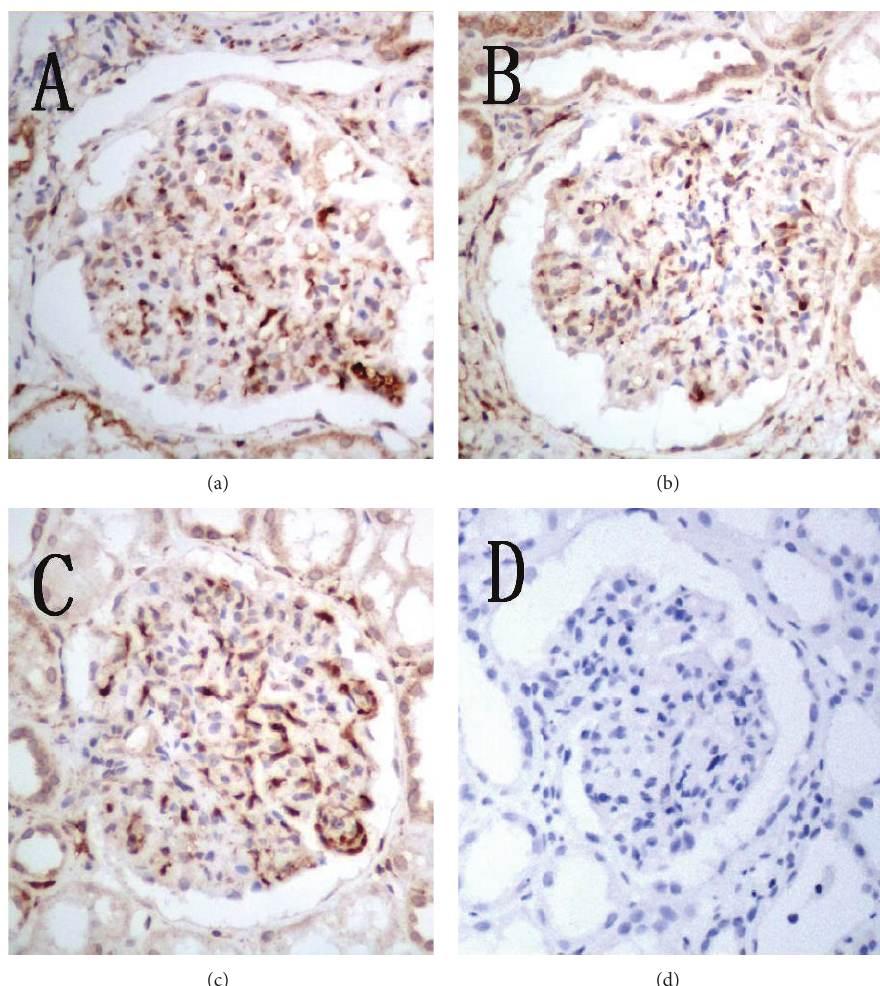
Figure 1: Immunohistochemical staining. (a) AIM2 positive staining in glomerular endothelial cells and mesangial cells in HBV-GN (magnification of 400x). (b) Caspase-1 positive staining in glomerular endothelial cells and mesangial cells in HBV-GN (magnification of 400x). (c) IL-1 𝛽 positive staining in glomerular endothelial cells and mesangial cells in HBV-GN (magnification of 400x). (d) AIM2, caspase-1, and IL-1 𝛽 negative staining with PBS substituted primary antibody in glomerular endothelial cells and mesangial cells in HBV-GN (magnification of 400x).